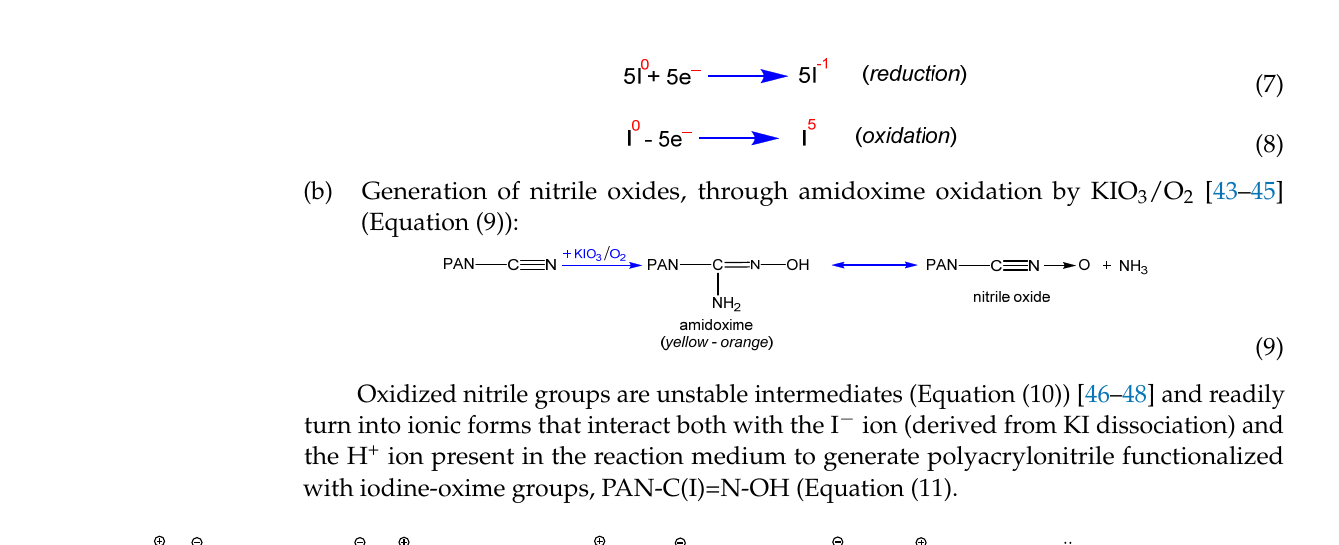
8 of 29 iodine in the reaction mixture. These functionalization reactions determine the permanent coloration of acrylic fibers in yellow-orange shades [40]. Chemical reactions involved in the conversion of nitrile groups of PAN chains in the above-mentioned functional groups are as follows: (a) Conversion to amidoxime groups placed on the polymeric chain (Equations (2) and (3)), and in situ obtaining of potassium iodate at 120 °C (Equations (4)–(8)):